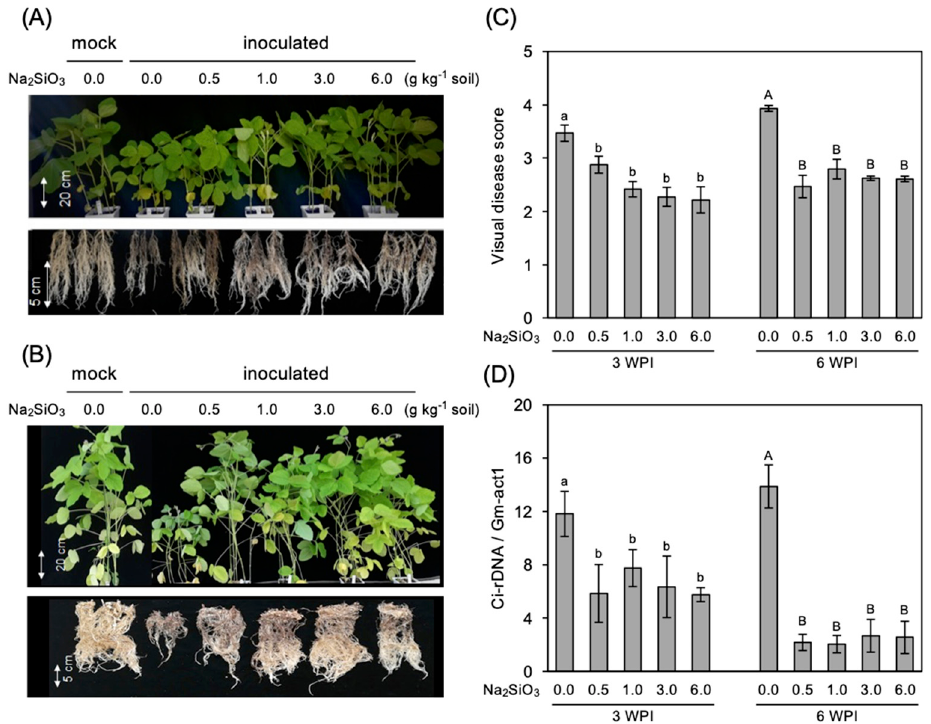
Figure 1. Plant growth parameters at 3 WPI ( A ) and 6 WPI ( B ), visual disease severity ( C ), and relative growth of Calonectria ilicicola in the roots of infected soybean seedlings at 3 and 6 WPI ( D ) ( n = 12). Different letters (lowercase for 3 WPI, uppercase for 6 WPI) indicate significant differences among treatments at different sampling time points ( p < 0.05), as per Tukey’s HSD